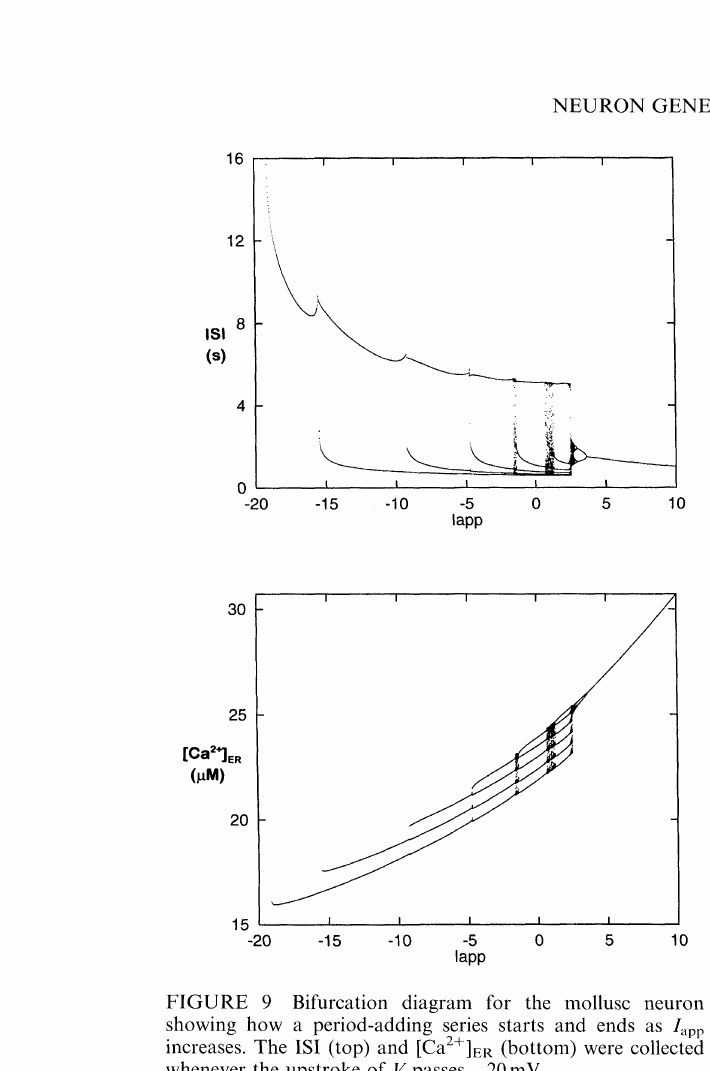
FIGURE 9 Bifurcation diagram for the mollusc neuron showing how a period-adding series starts and ends as Iapv increases. The ISI (top) and [Ca2+]E R (bottom) were collected whenever the upstroke of V passes -20